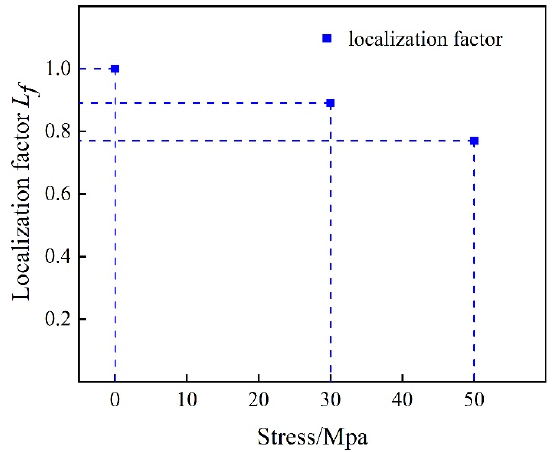
Figure 18. Localization factor under di ff erent stress stages.